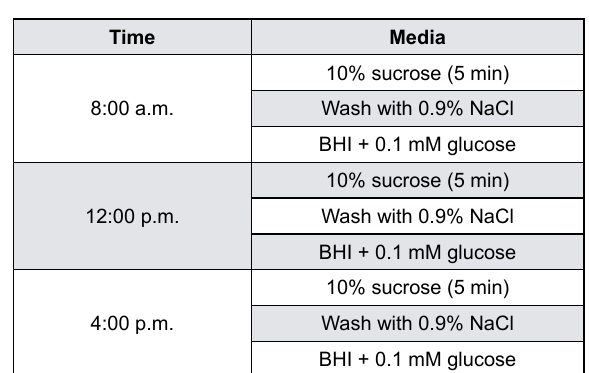
Figure 3- Image of enamel slabs positioned in cell plates